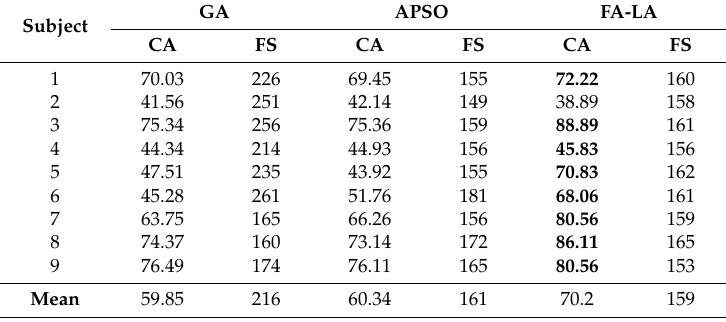
Table 4. Comparison of classification accuracy (CA, %) and the number of the features selected (FS) between the three algorithms: GA, APSO, and FA-LA, for data set 2a from the 2008 BCI